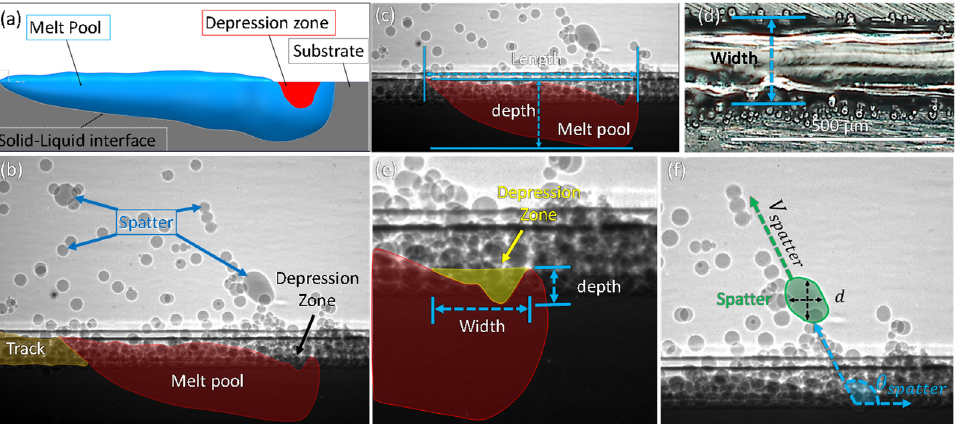
Figure 3. Dynamics of SLM. ( a ) Schematic outlining dynamics during laser scanning. ( b ) The key features observed by in-situ X-ray imaging. ( c ) Typical melt pool length and depth dimensions. ( d ) Typical optical image of the melt pool width measured after laser melting and removal of excess powder. ( e ) Typical depression zone depth and width dimensions. ( f ) Typical X-ray image showing spatter dynamics. The spatter diameter, d, spatter ejection angle, θ , and spatter speed, V spatter , are indicated in the image.